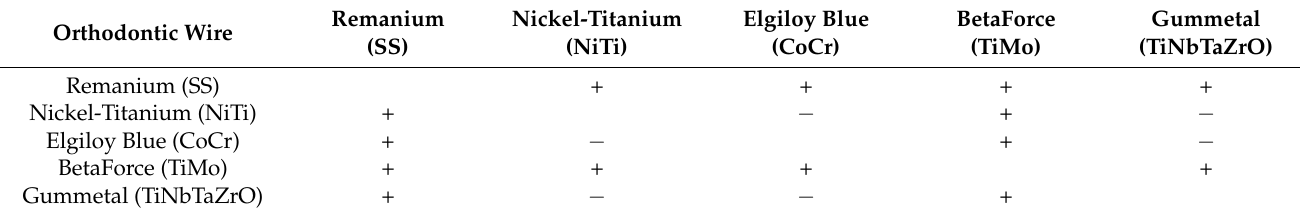
Gummetal (TiNbTaZrO) + − − + Seven out of ten pairwise group comparisons turned out to be statistically significant. Remanium and BetaForce group sample means both showed a significant difference be- tween each other and between all the other groups. On the other hand, no statistically significant differences were found between pairwise comparisons of Nickel-Titanium, Gummetal, and Elgiloy Blue sample group means. Among the studied groups, the lowest values of kinetic FFs were exerted by Remanium, the highest ones—by BetaForce; the medium forces were shown by Elgiloy Blue, Nickel-Titanium, and